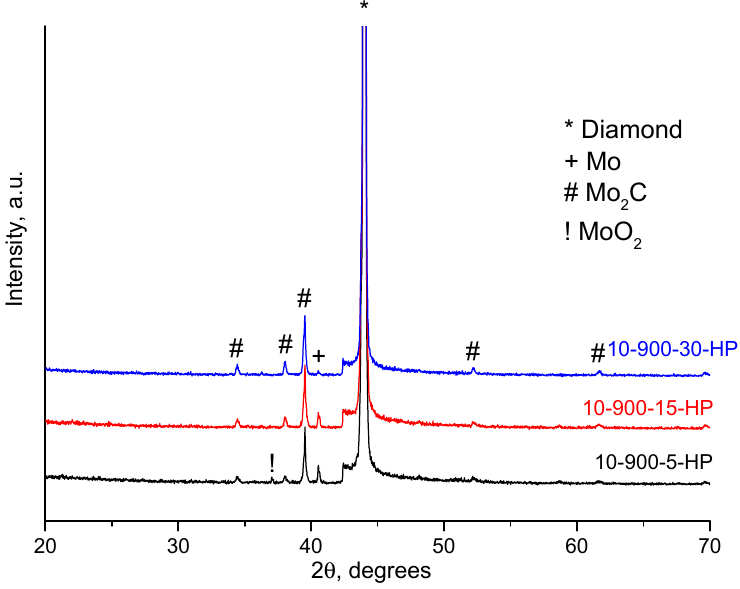
Figure 3. XRD patterns of the samples obtained at 900 °C (different holding times).